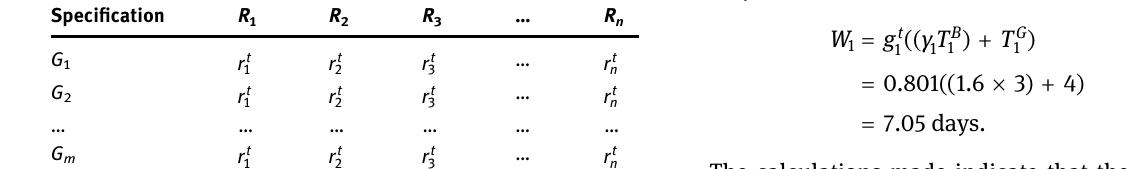
Table 4: Matrix of allocation of risk R i factors for individual sur - veying tasks G i Speci fi cation